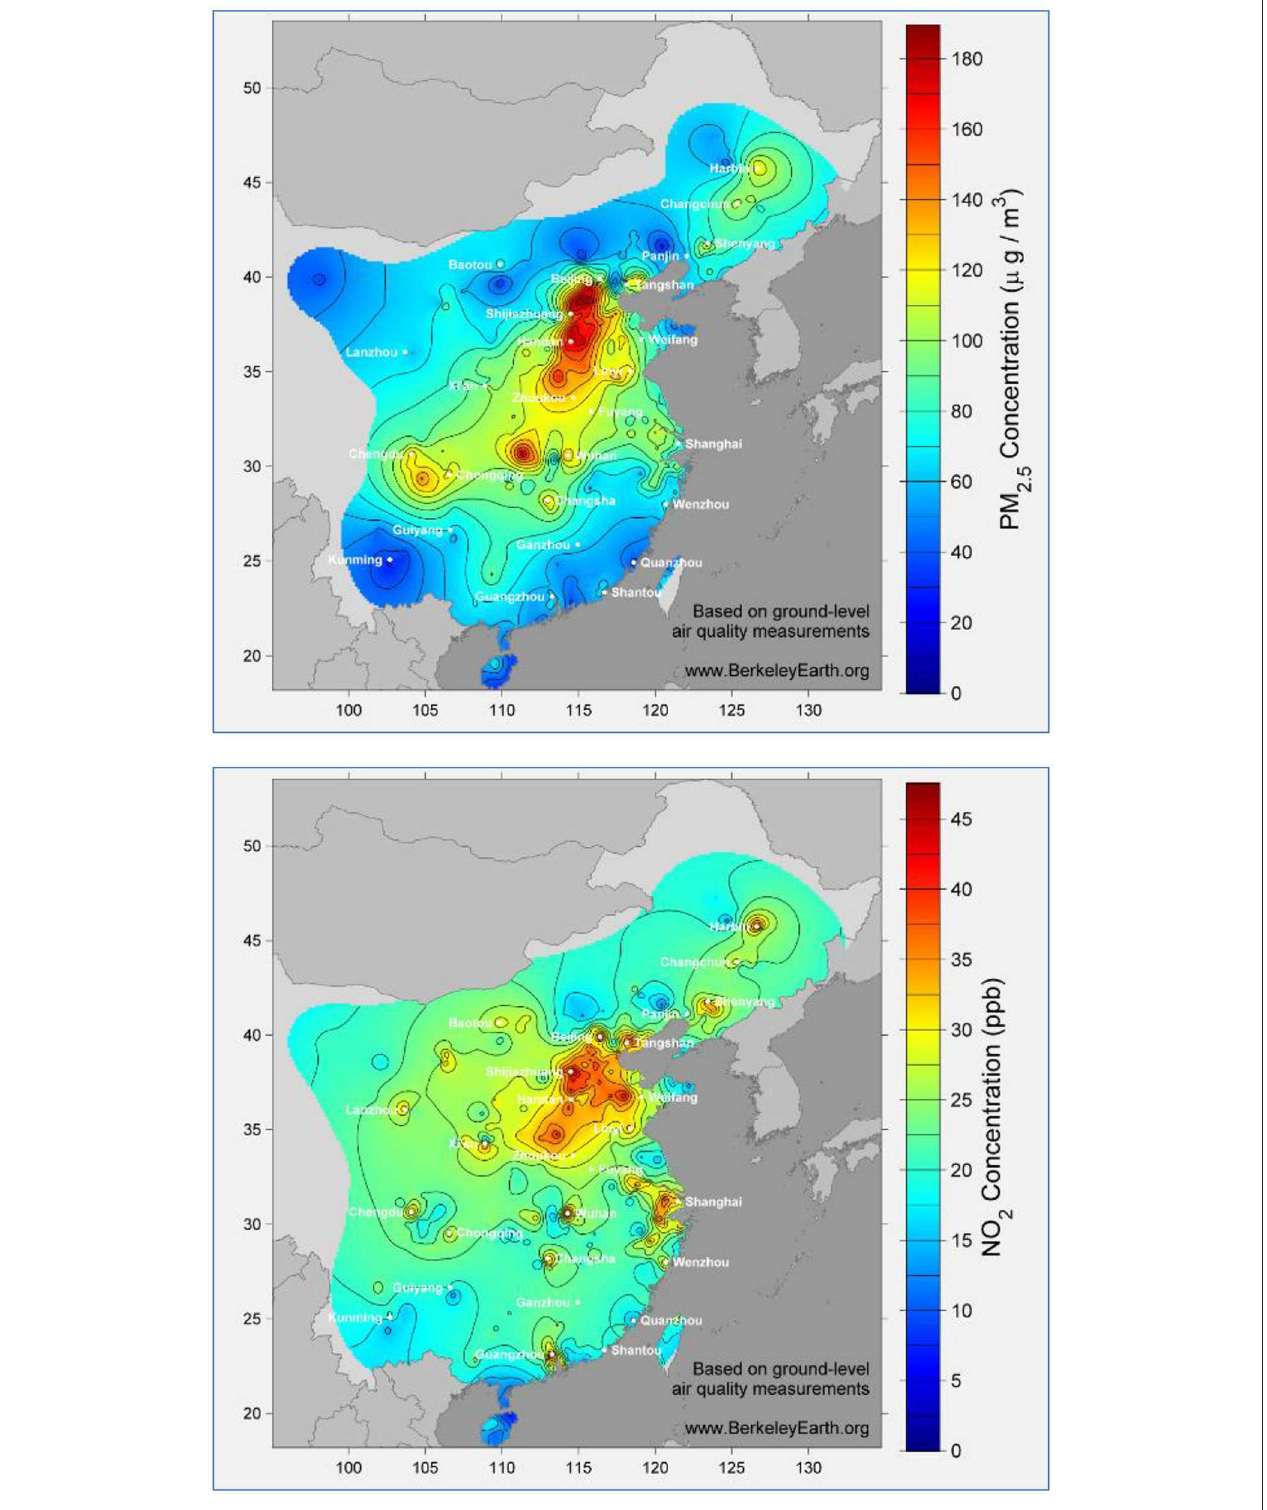
FIGURE 3 | Average monthly concentrations for China during January 2015 of PM 2.5 , top, and NO 2 , bottom. Images from Berkeley Earth, www.berkeleyearth.org.